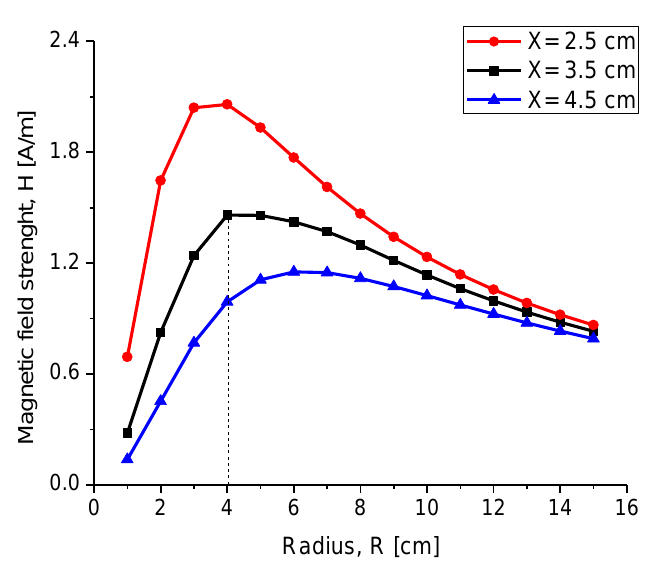
Figure 4. The intensity of field H for the external coil as a function of external radius R out.r considering three radiation distances X.